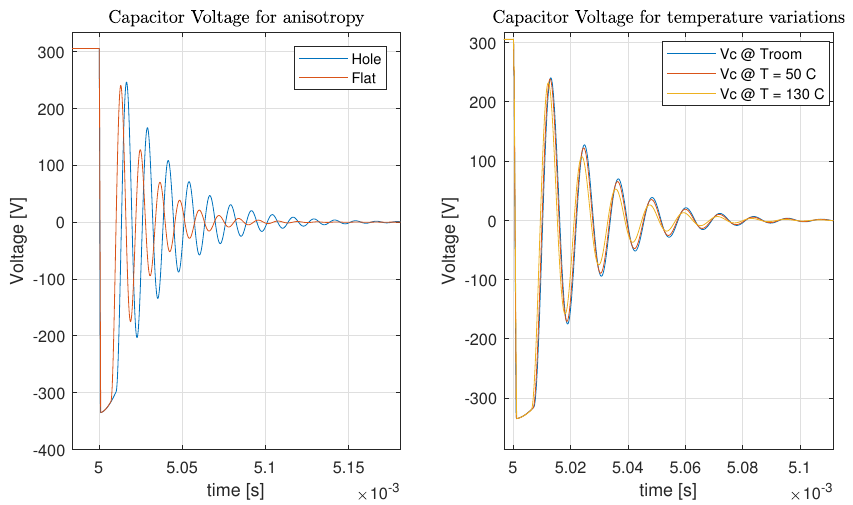
Figure 6. Natural time transient of capacitor voltage for the standard workpiece and for anisotropy presence ( left ) and capacitor voltage for different average temperatures of the workpiece sur- face ( right